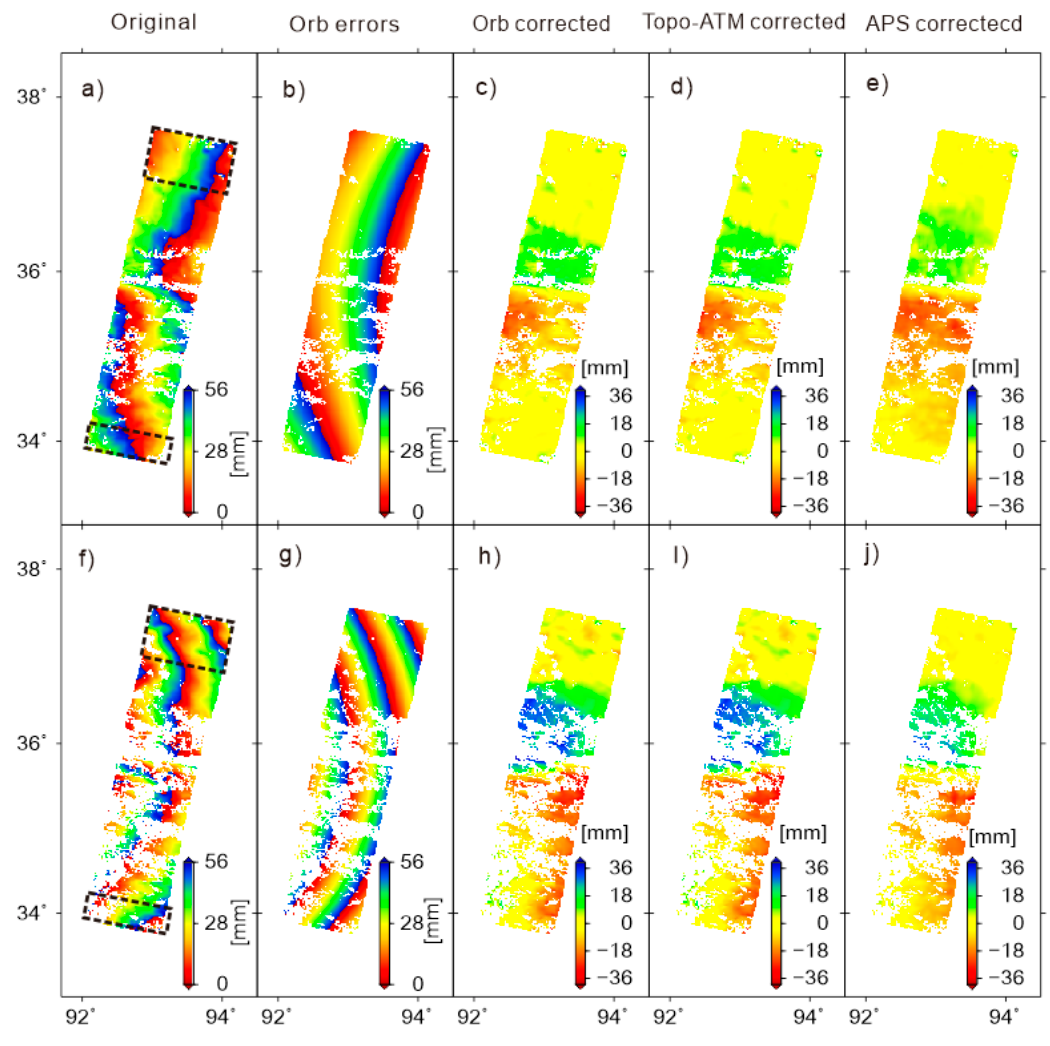
Figure 3. Two examples of InSAR phase error corrections for interferograms (20050929–20090730, 20061019–20090205) on track 133; ( a , f ) Original unwrapped interferograms; ( b , g ) Estimates of quadratic orbital ramp errors; ( c , h ) Interferograms following orbital error correction; ( d , i ) Interferograms corrected for topographically correlated atmospheric delay errors;. ( e , j ) Interferograms corrected using spatiotemporal filters to mitigate residual atmospheric phase screen (APS). Note that different color scales are applied for some subplots. The black boxes in ( a ) and ( f ) are defined as “far-field” and are used to construct the quadratic model in the orbital error correction.